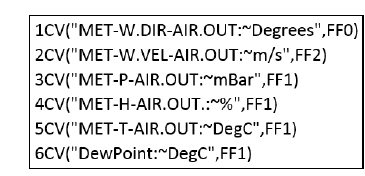
Fig. 9.The weather station sensor data acquisition program.